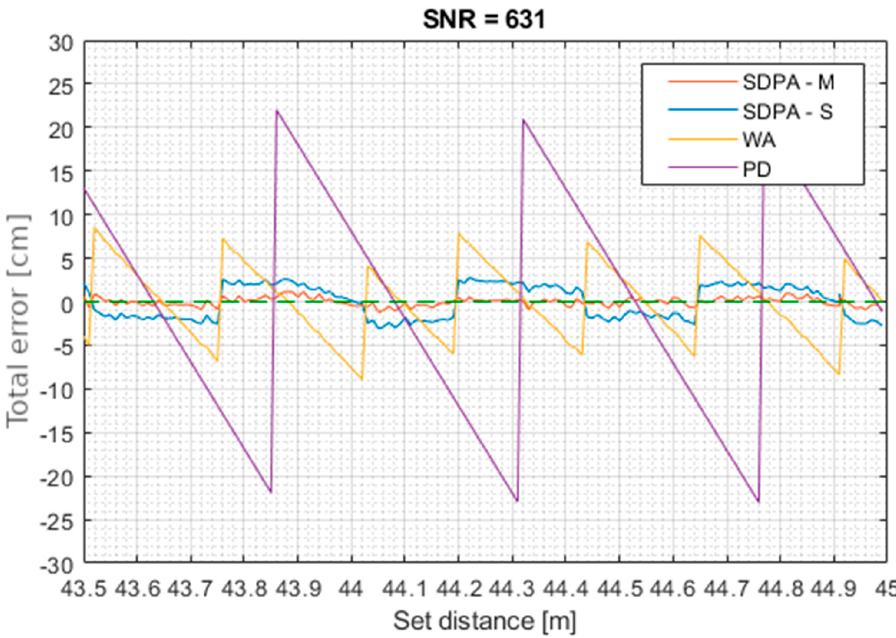
Figure 15. Trial 2. Total error of measurements as a function of set distance for SNR = 631. The measurement uncertainty U s of each algorithm was estimated using formula